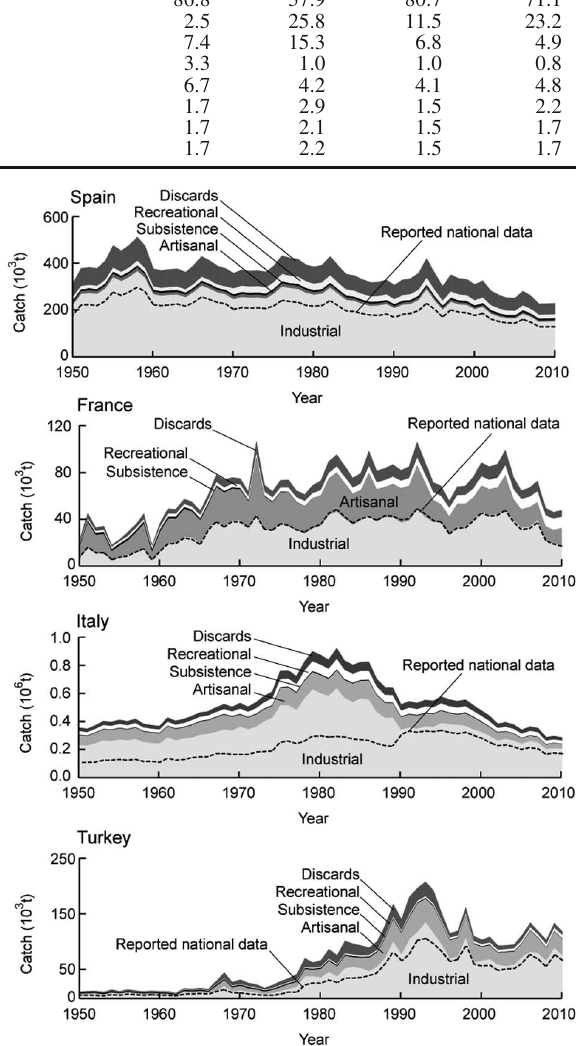
Fig. 2. – Total reconstructed catch by sector, compared with na- tional reported data for the four countries in the Mediterranean Sea from